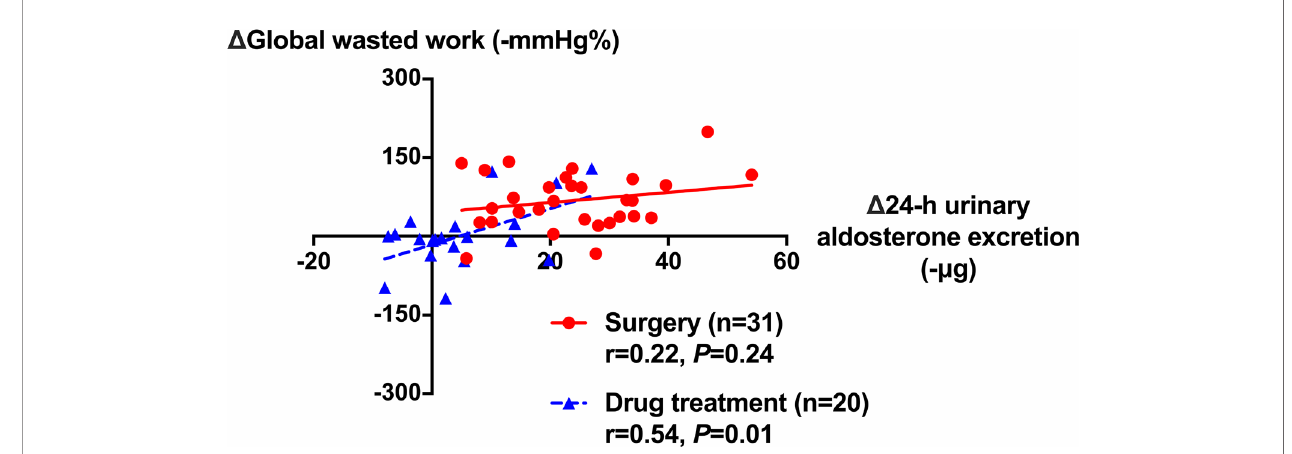
FIGURE 4 | Correlation between the changes in global wasted work of the left ventricle and that in 24-h urinary aldosterone excretion during follow-up in patients treated with surgery (circles with solid line) and drugs (triangles with dashed line). The correlation coef fi cients and corresponding p -values are given for each group.